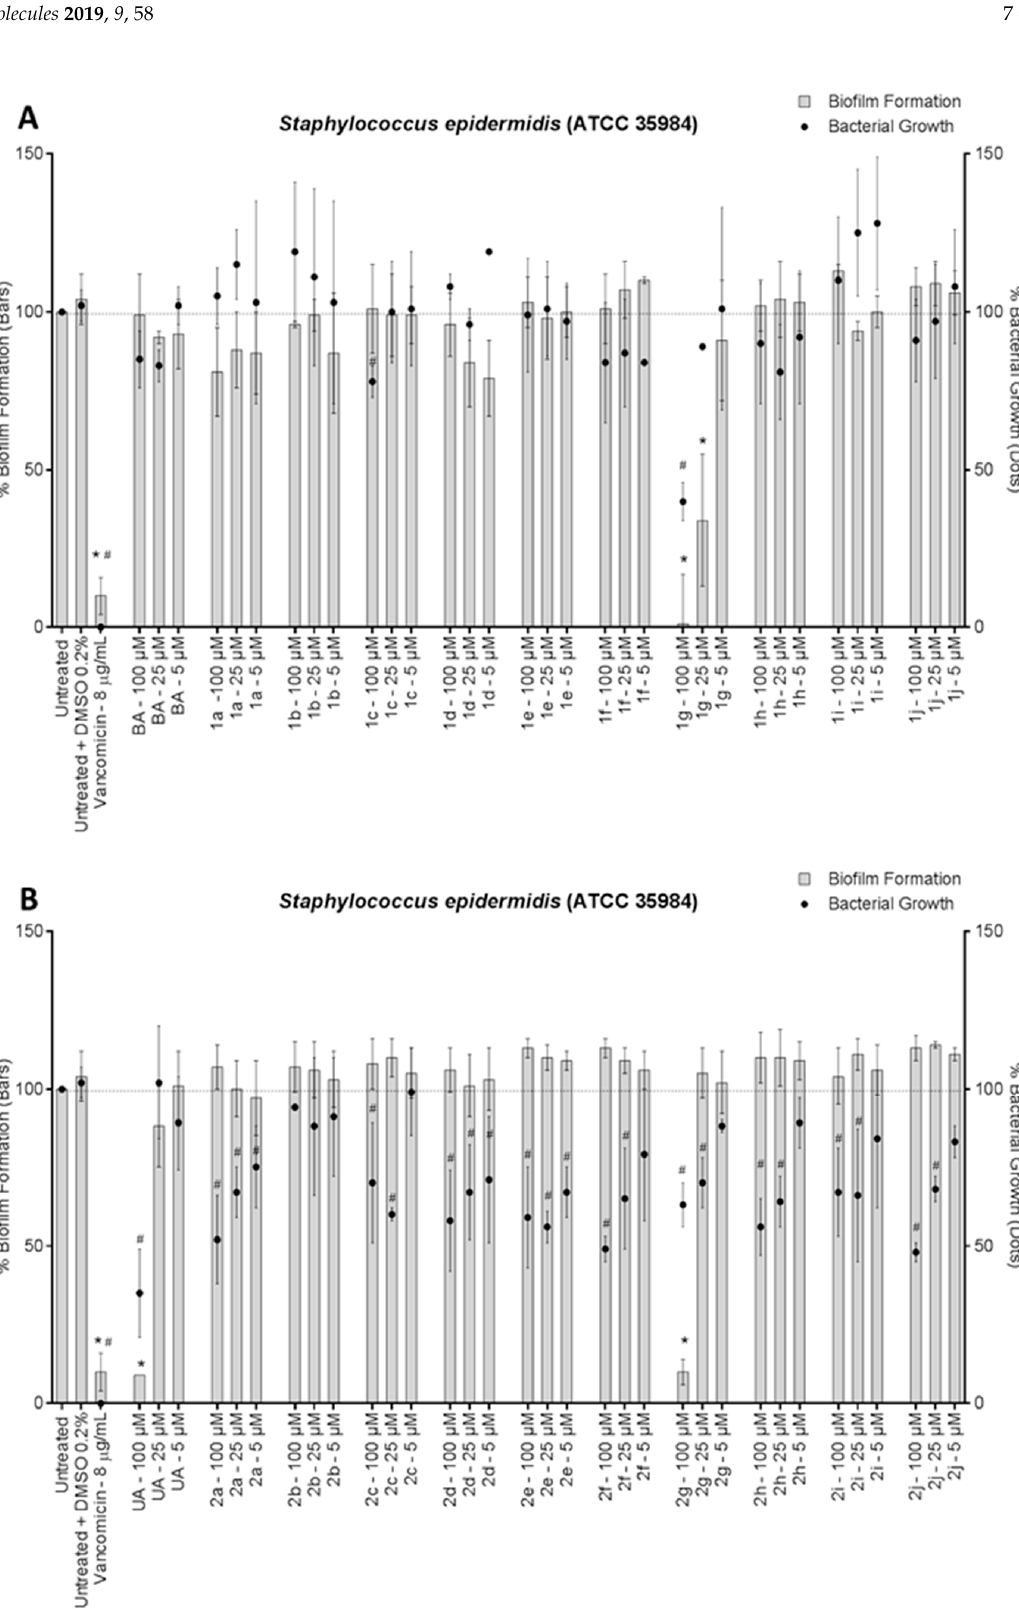
Figure 3. In vitro antibiofilm and antibacterial activity of Staphylococcus epidermidis : ( A ) BA and derivatives; ( B ) UA and derivatives. Results represent mean ± standard deviation of five experiments. * Represents significant difference in relation to biofilm formation control ( p < 0.01). # Represents significant difference in relation to planktonic cells viability control ( p <